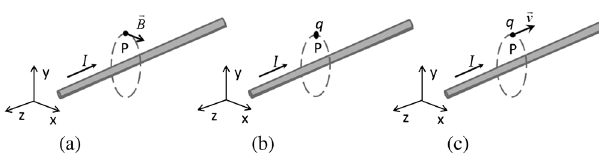
FIG. 2. Final version of the Magnetic Field question designed by the authors of the paper.